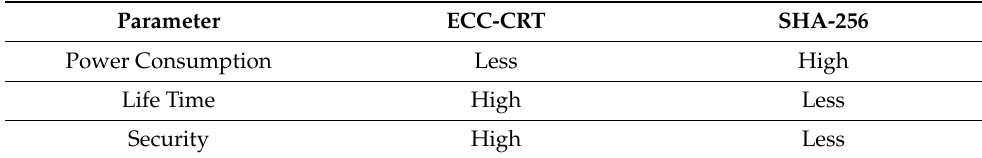
Figure 11. Storage space for ECC-CRT and SHA-256. Table 3. Comparison between ECC-CRT and